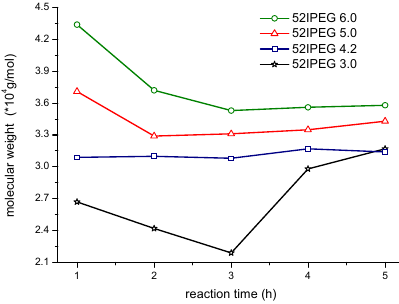
Figure 2. Molecular weight of 52IPEG PCEs via SEC spectra.